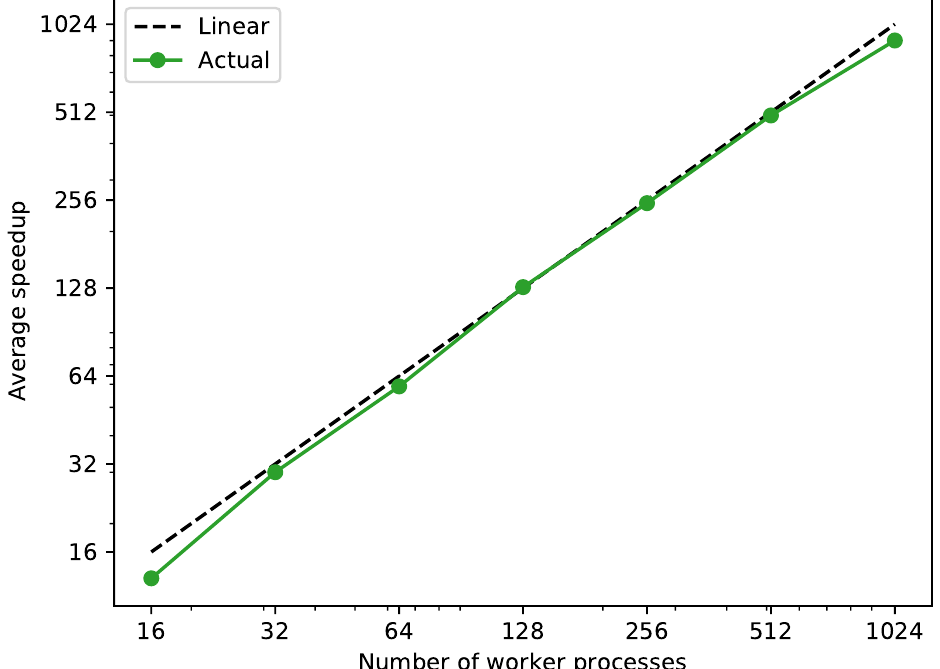
Figure 8. Average speedup against sequential simulation of the 2400 scenarios generated in test case 2 with a different number of worker